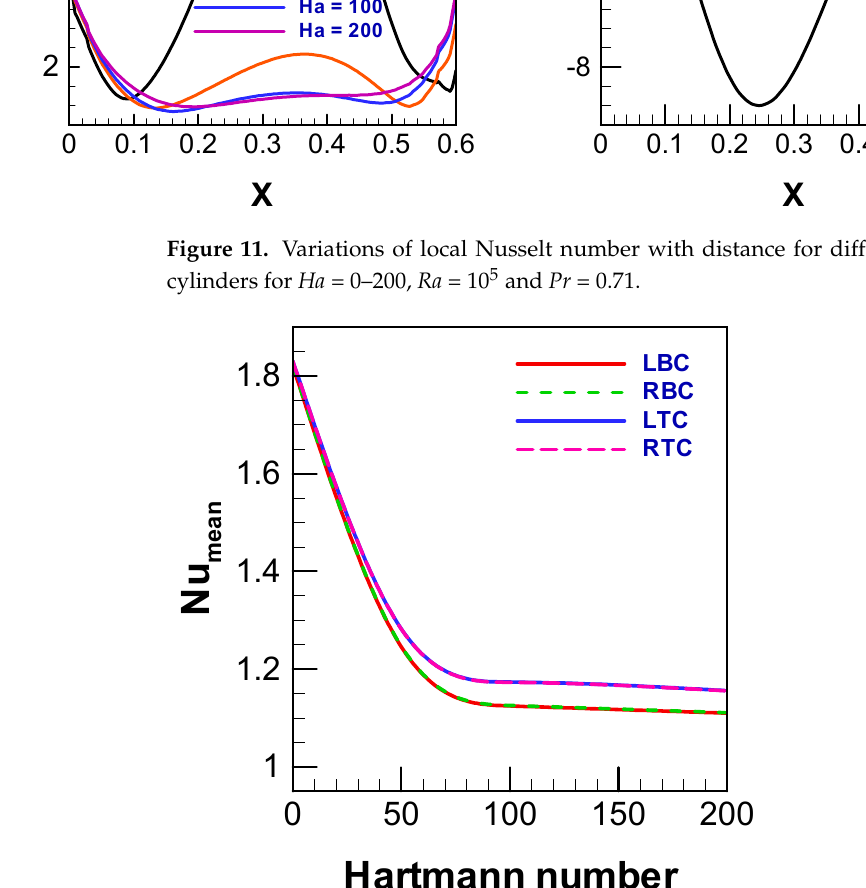
Figure 12. Variations of average Nusselt number with the Hartmann number for different orientations of heated cylinders for Ha = 0–200, Ra = 10 5 and Pr = 0.71 .